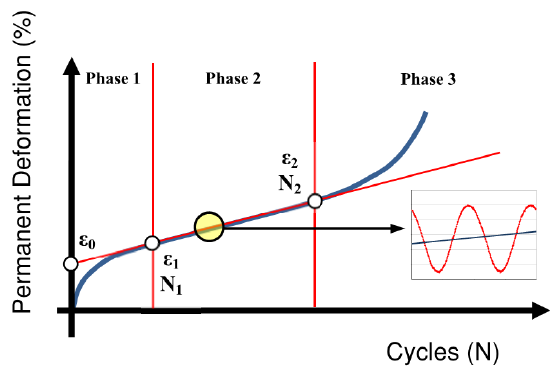
Figure 10. Evaluation of permanent deformation [33].